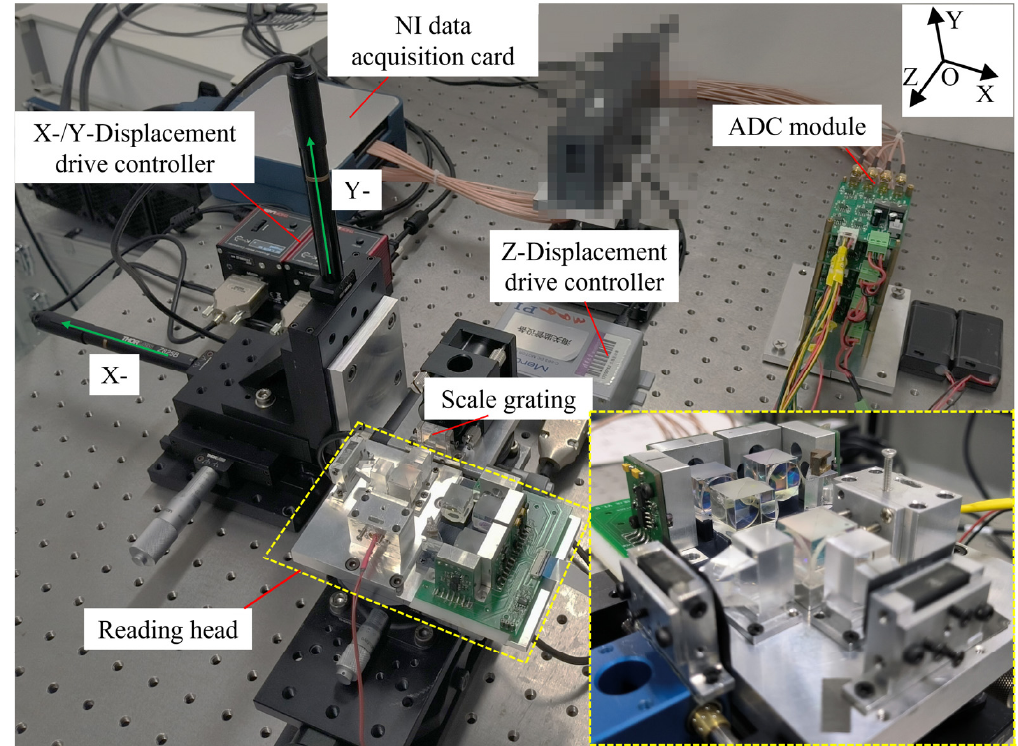
Figure 3. Three-DOF grating encoder test platform.